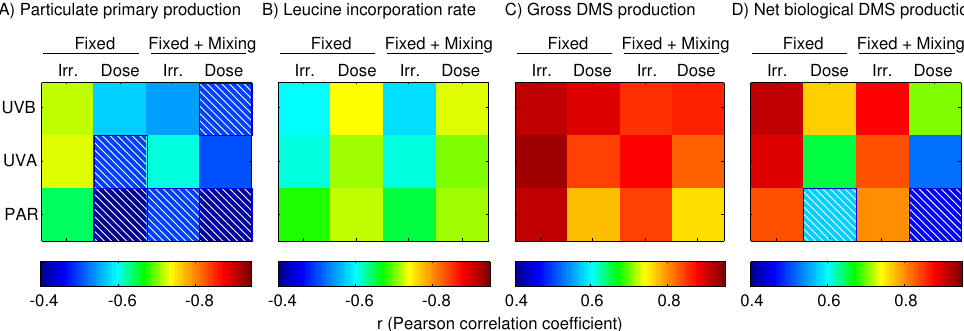
Fig. 8. Pearson’s correlation coefficient ( r ) between biogeochemical process rates and mean incubation irradiance (Irr.) or cumulative dose in different radiation bands (UVB, UVA and PAR), in fixed bottles only and in the ensemble of fixed + mixing bottles. Note that r is negative in (a) and (b) and positive in (c) and (d) . The diagonal stripe pattern indicates non-significant r ( p